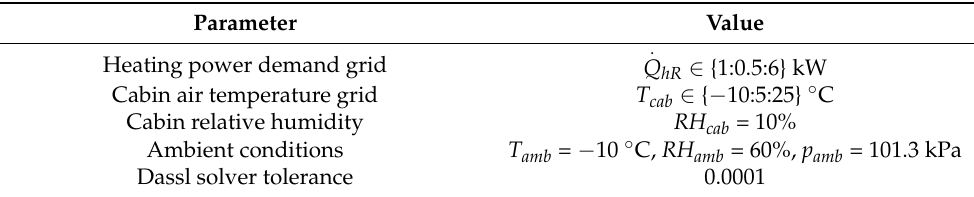
Table 2. Basic optimisation and simulation model setting